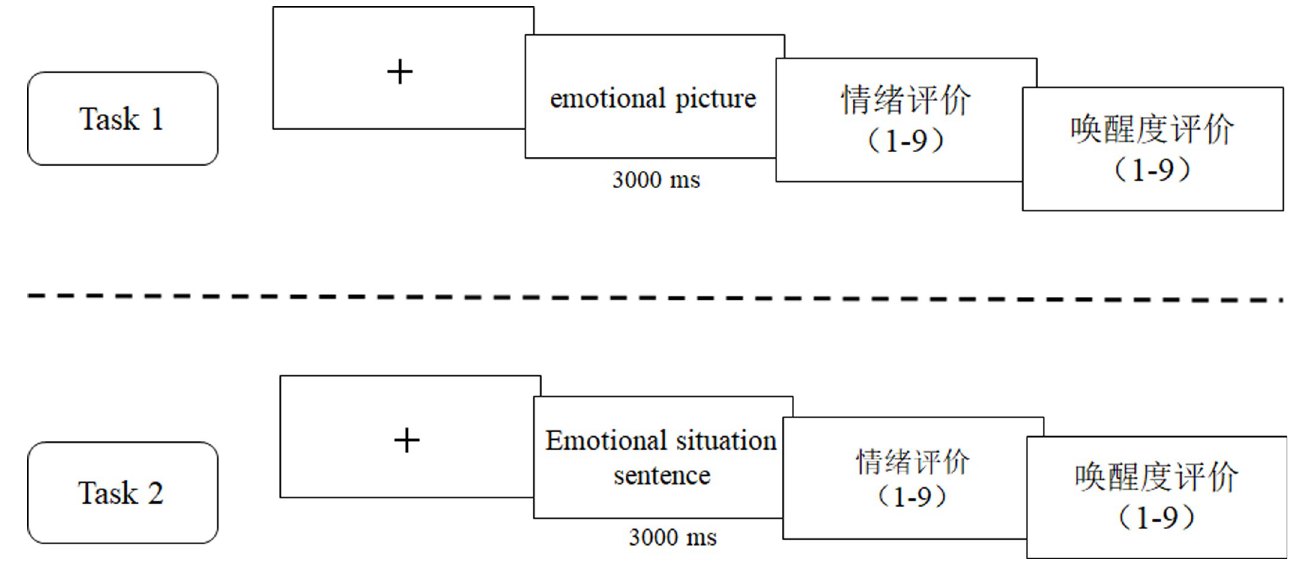
Fig 5. The experimental procedure of study